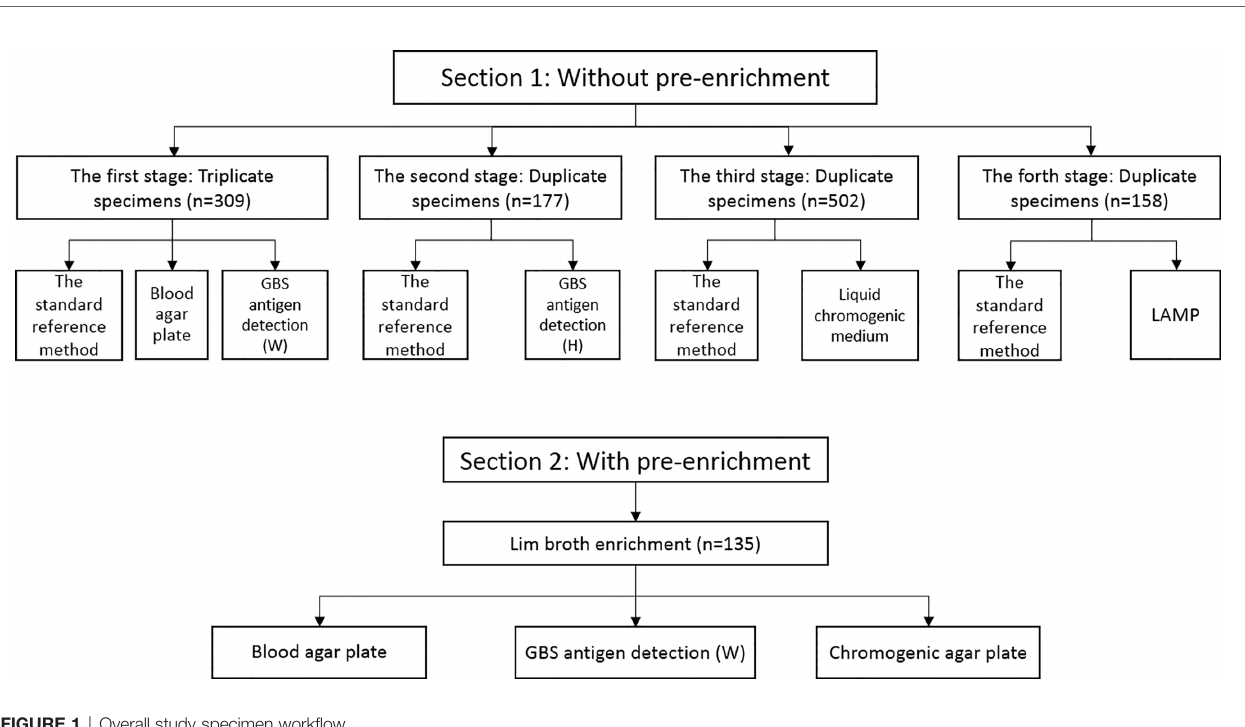
FIGURE 1 | Overall study specimen work fl